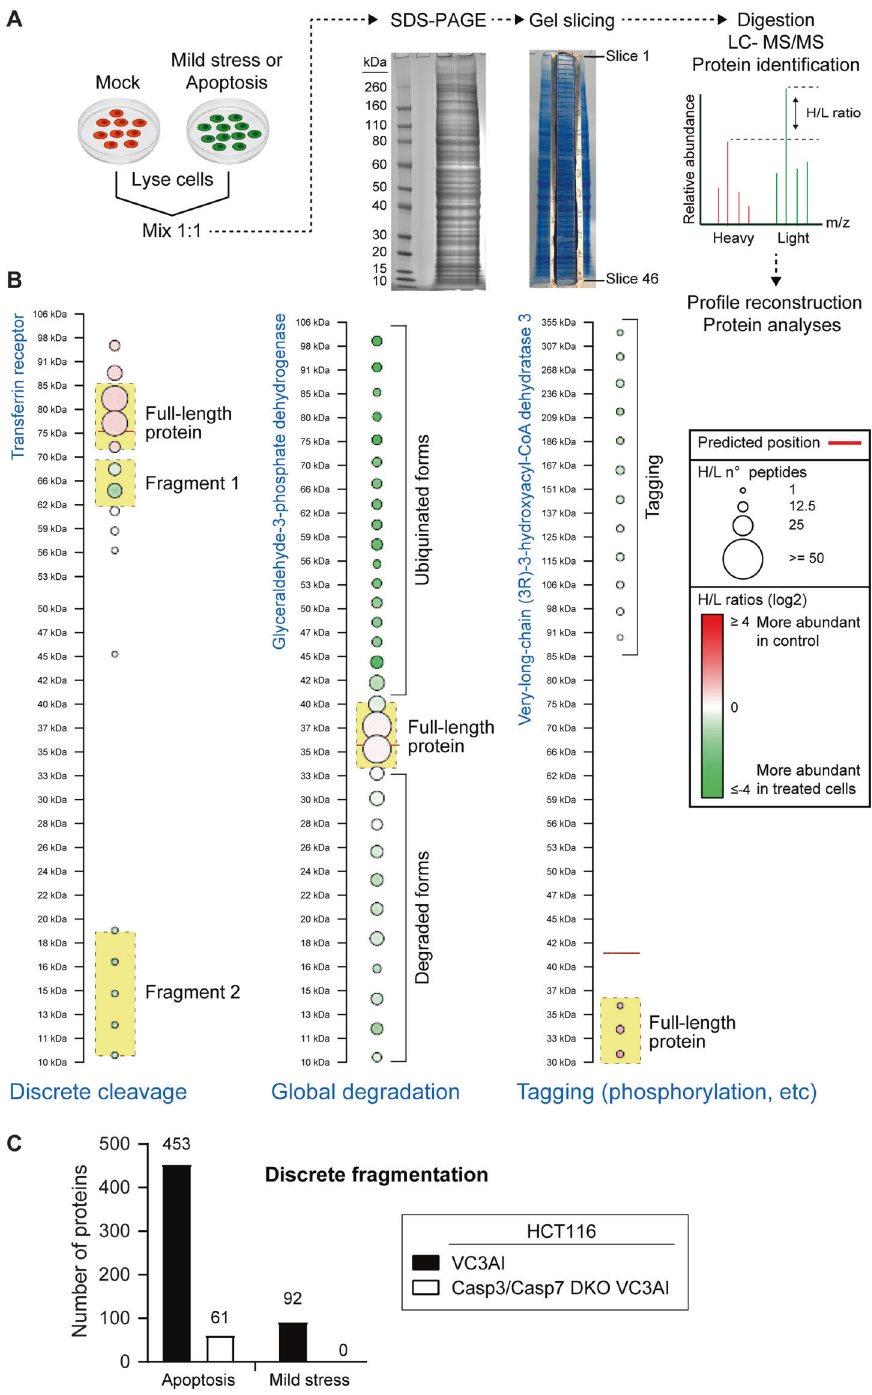
Fig. 3 PTMs in mild stress and apoptosis. A Scheme depicting the SLICE-SILAC methodology. Cells labeled with normal (light) or heavy amino acid isotopes (red and green cells, respectively) are exposed to two different experimental conditions (in our case exposed or not to a given cisplatin concentration). The two populations are then mixed and loaded on an SDS-PAGE gel. Upon completion of electrophoresis, the gel is cut into ~50 slices that are individually subjected to trypsin digestion and analyzed by liquid chromatography with tandem mass spectrometry (LC – MS/MS). Because of the differential isotope labeling, it is possible to determine from which experimental condition a mass spectrometry-identi fi ed protein is coming from. Identi fi cation of a protein in a gel slice that does not correspond to its MW indicates that the protein has been subjected to PTMs. B Three examples of PTMs detected by the SLICE-SILAC methodology. C Number of proteins detected by the SLICE-SILAC procedure as cleaved under non-lethal stress and during apoptosis in VC3AI HCT116 and CASP3/CASP7 DKO VC3AI HCT116 cells.